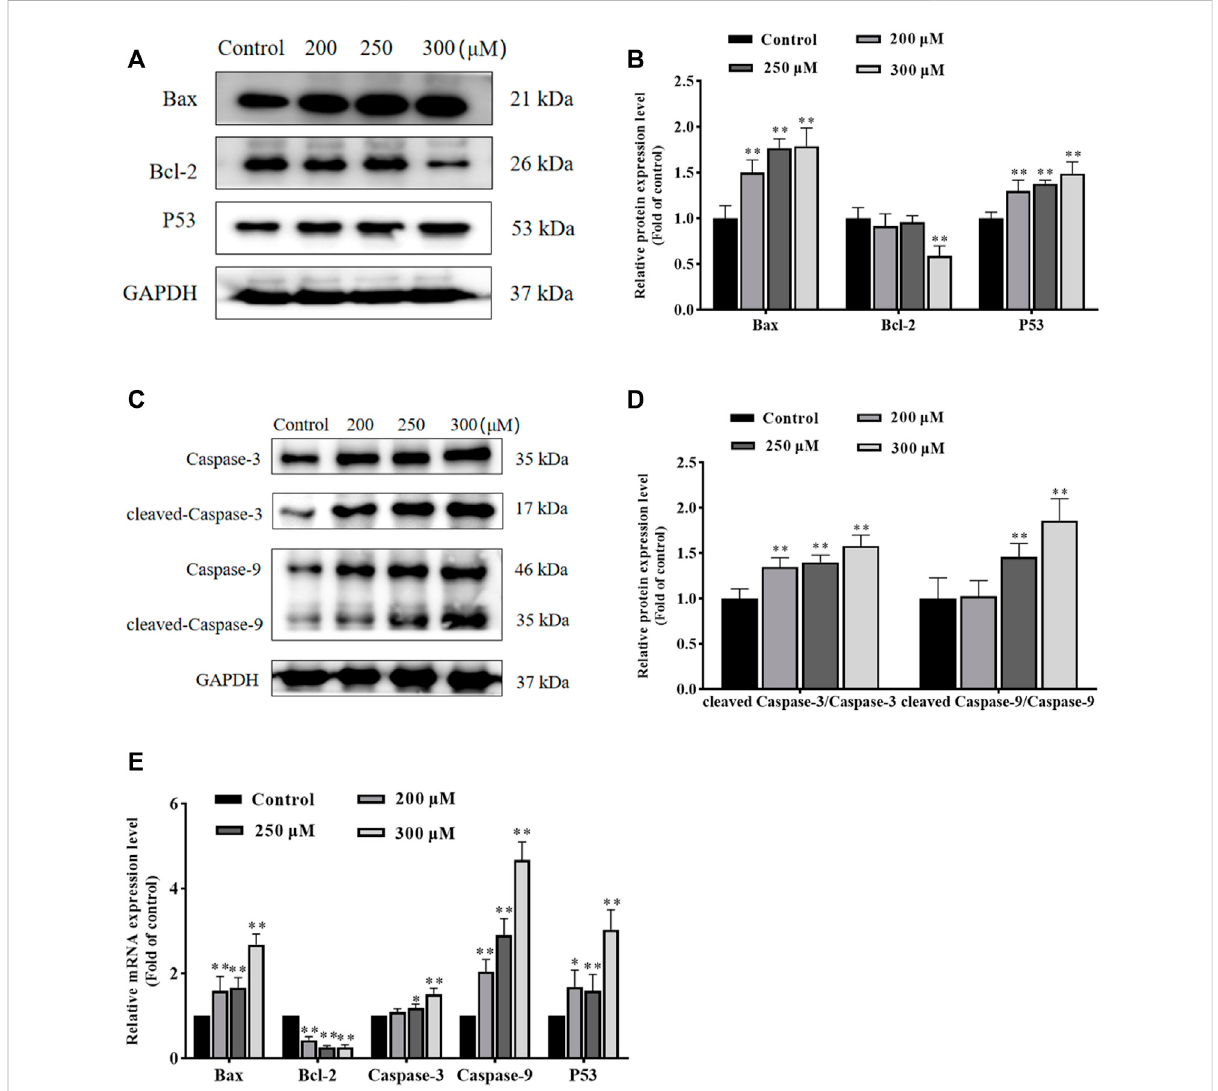
FIGURE 3 GA induces HCC1806 cells apoptosis via the mitochondrial pathway. (A – D) Effect of GA on the expression of Bax, Bcl-2, cleaved-Caspase-3, cleaved-Caspase-9 and P53 proteins in HCC1806 cells. (E) Effect of GA on the expression of Bax, Bcl-2, Caspase-3, Caspase-9 and P53 mRNA